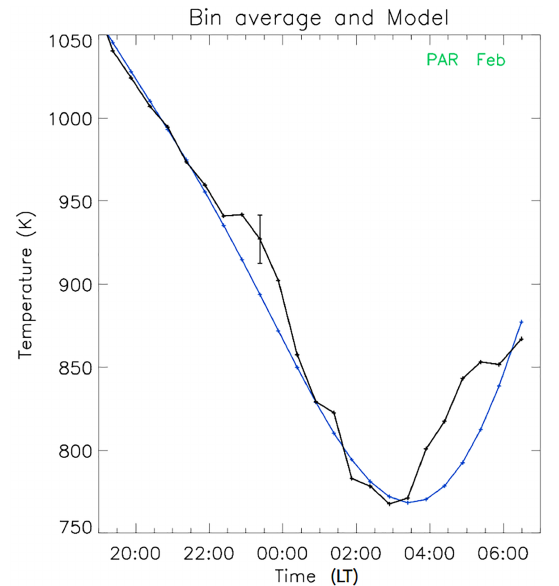
Figure 3. Monthly climatology plot of the temperature data for nights with MTM events in the months of February 2012, 2013, 2014, and 2015. The blue curve represents the thermal background and the black curve is the averaged data for PARI. The vertical er- ror bar is a representative depiction of the averaged measurement errors.